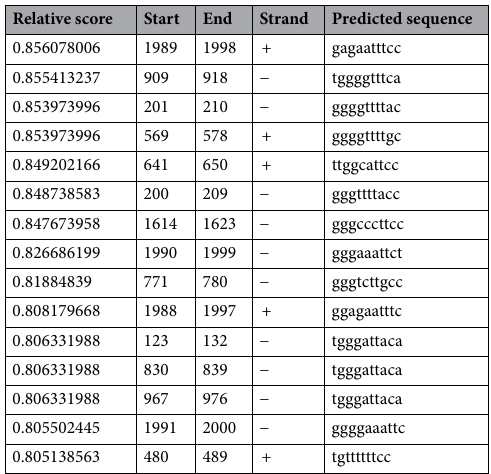
Table 2. Prediction of human-RelA binding to human- HNF1A